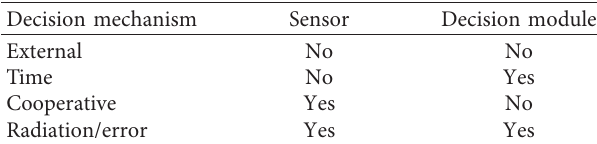
Table 1: Decision